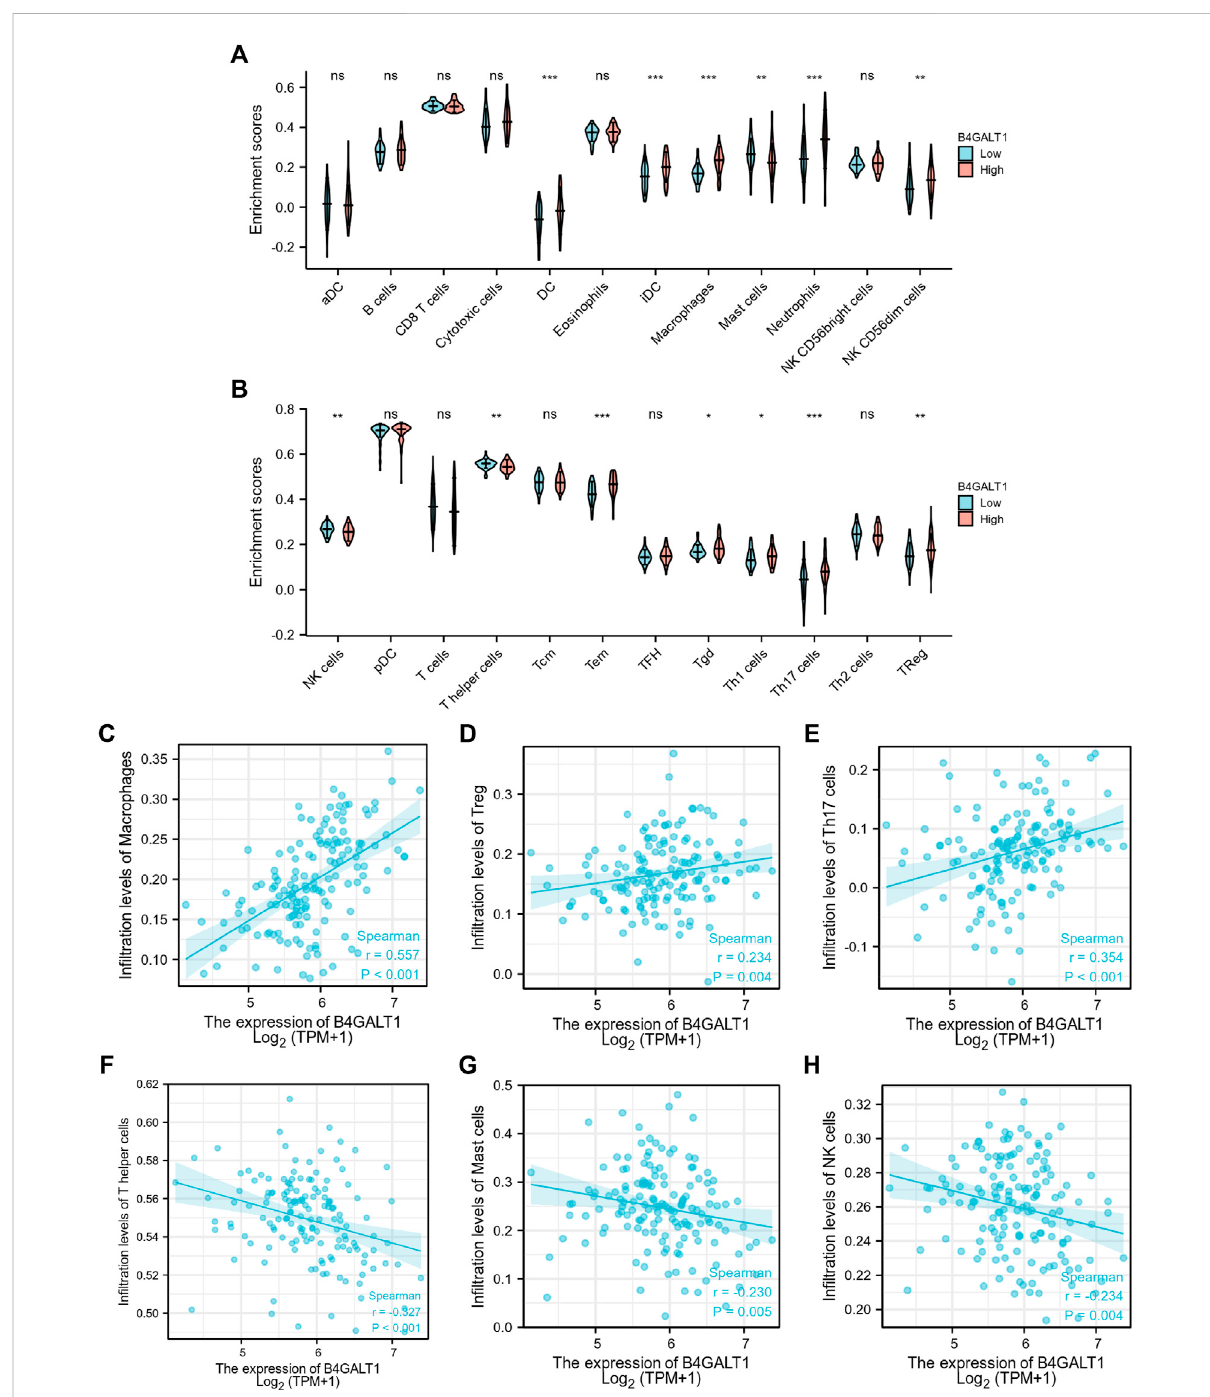
FIGURE 9 Correlationbetweenthein fi ltrationlevelof24immunecellsandtheexpressionlevelofB4GALT1. (A-B) Differentialdistributionofimmunecells in patients with high B4GALT1 expression and low B4GALT1 expression. (C-H) Correlation between the expression level of B4GALT1 and immune in fi ltration in acute myeloid leukemia (LAML): (C) Macrophages, (D) regulatory T-cell, (E) Th17 cells, (F) T helper cells, (G) Mast cells, (H) NK cells. NS: p ≥ 0.05; *, p < 0.05; **, p < 0.01; ***, p <